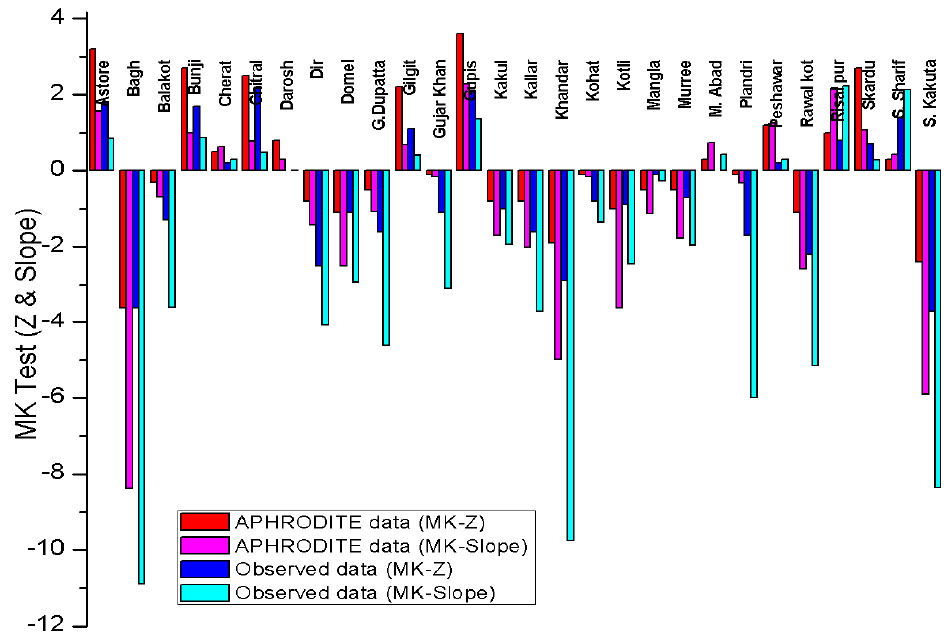
Figure 3. Comparison of Mann-Kendall (MK)-Z and slope of average monthly observed and APHRODITE precipitation data.